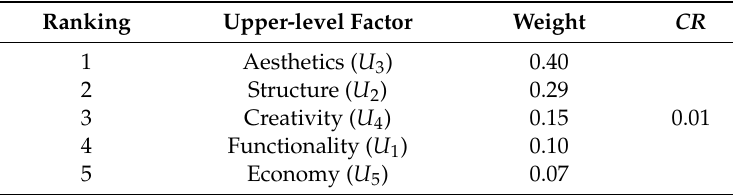
Table 3. Weight set of upper-level factors of evaluation indices for a pillbox design for patients with chronic diseases.